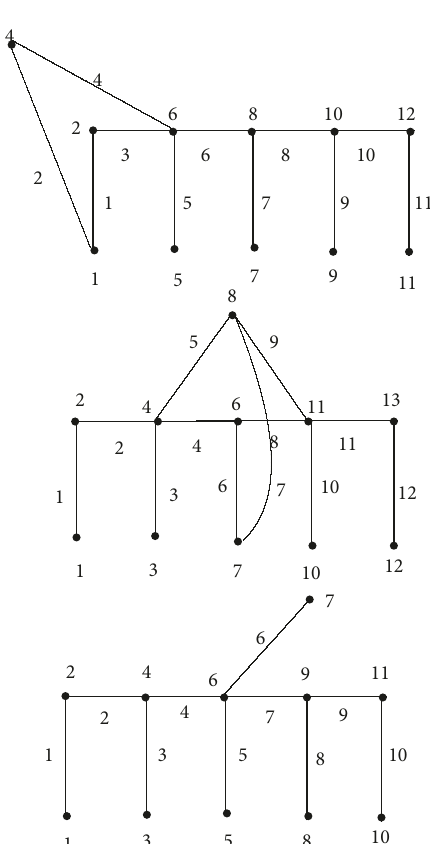
Figure 8: A classical mean labeling of G obtained by duplicating a vertex of the graph P